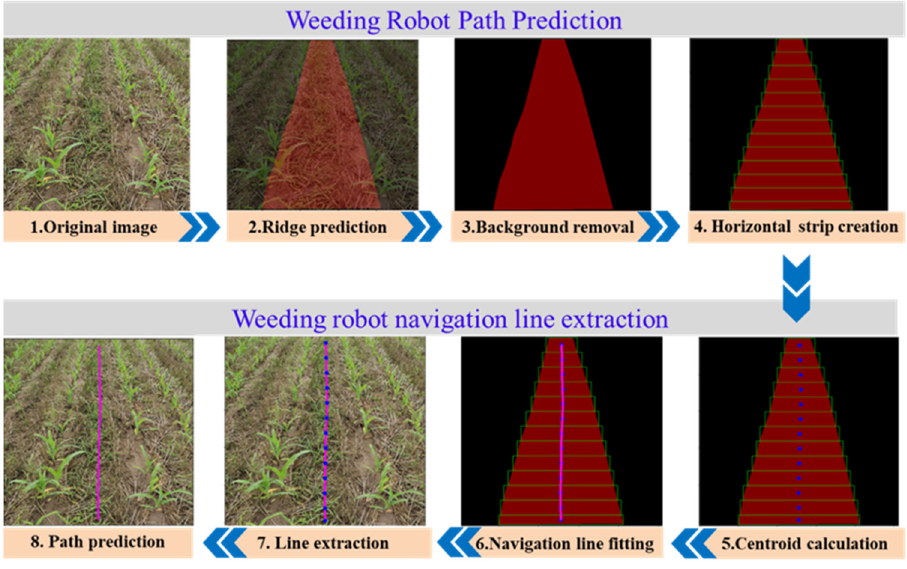
Figure 8. Main procedures of this paper.